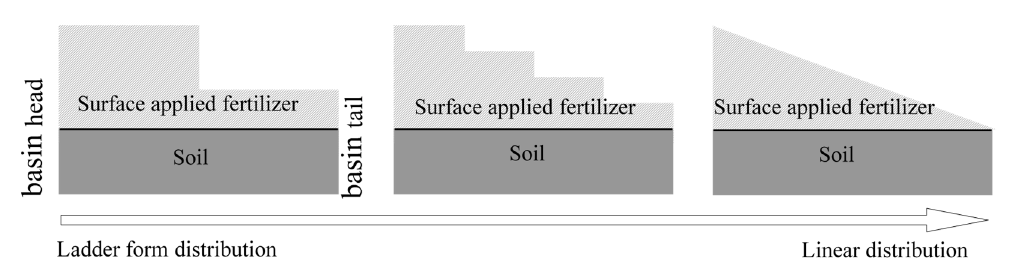
Figure 1. Schematic of non-uniform broadcast fertilization.